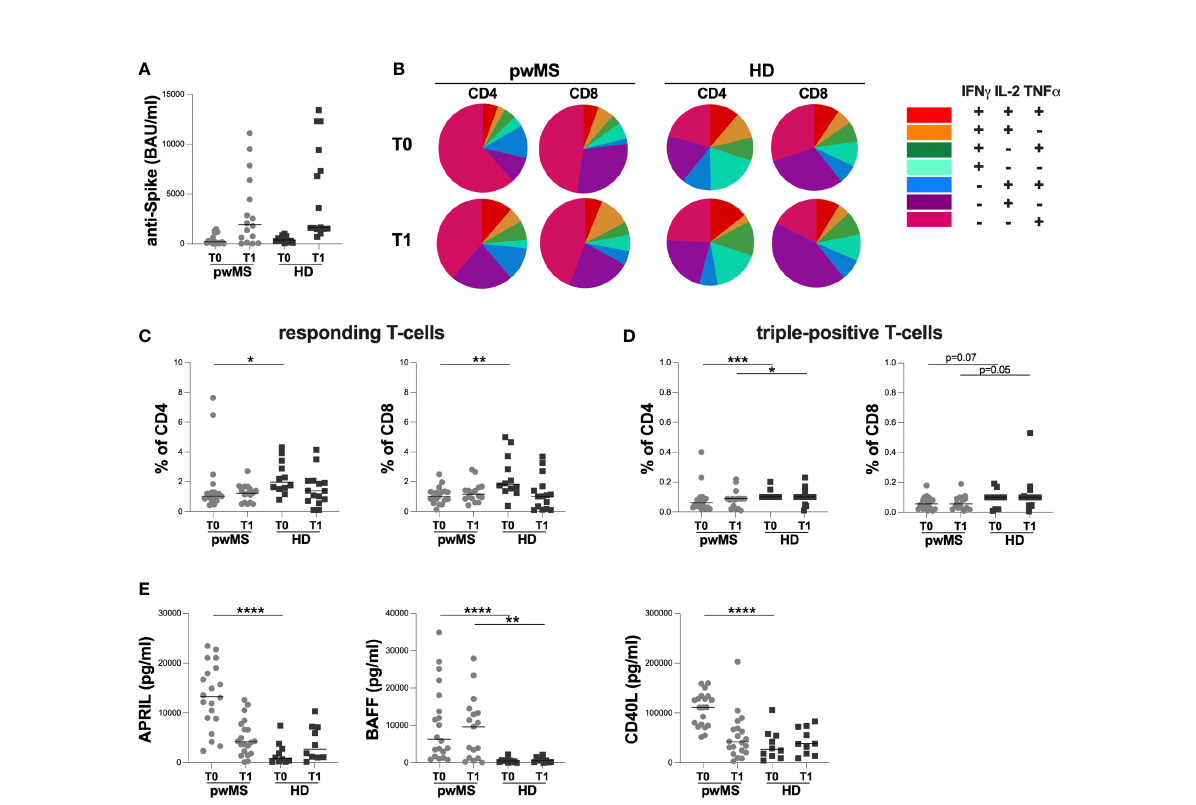
FIGURE 2 Cross-sectional evaluation of humoral and speci fi c T-cell response in pwMS and HD, and overview of cytokine-producing T-cells. (A) The evaluation of anti-S antibody titers in pwMS and HD. (B) Overview of intracellular IFN g ,IL2 and TNF a production by CD4+ and CD8+ T-cells at T0 and at T1 in pwMS and HD. (C) Evaluation of percentage in responding CD4+ and CD8+ T-cells in pwMS and HD. (D) Evaluation of percentage in triple-positive CD4+ and CD8+ T-cells in pwMS and HD. (E) Evaluation of plasma levels of APRIL, BAFF and CD40L in pwMS and HD. APRIL, A-proliferation inducing ligand; BAFF, B-cell activating factor; CD40L, CD40 ligand; pwMS, people with multiple sclerosis; HD, healthy donors; T0, before third dose of vaccine; T1, after two months form third dose of vaccine. *p < 0.05; **p < 0.01; ***p < 0.001; ****p <